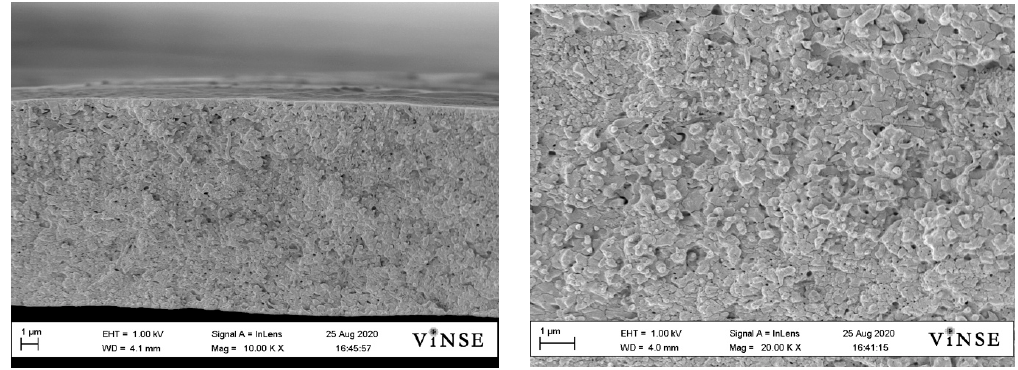
Figure 5. Low ( left ) and high ( right ) magnification SEM images of freeze-fractured cross sections of a fully processed membrane (Membrane Type-A).